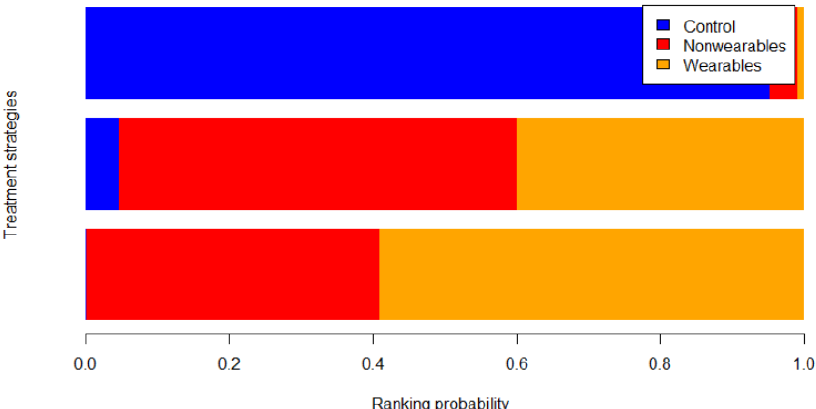
Figure 5. Stacked bar plot showing ranking probability of all treatment strategies. The network model suggests home exercise program informed by wearable activity monitor as the best treatment for improving walking outcomes.